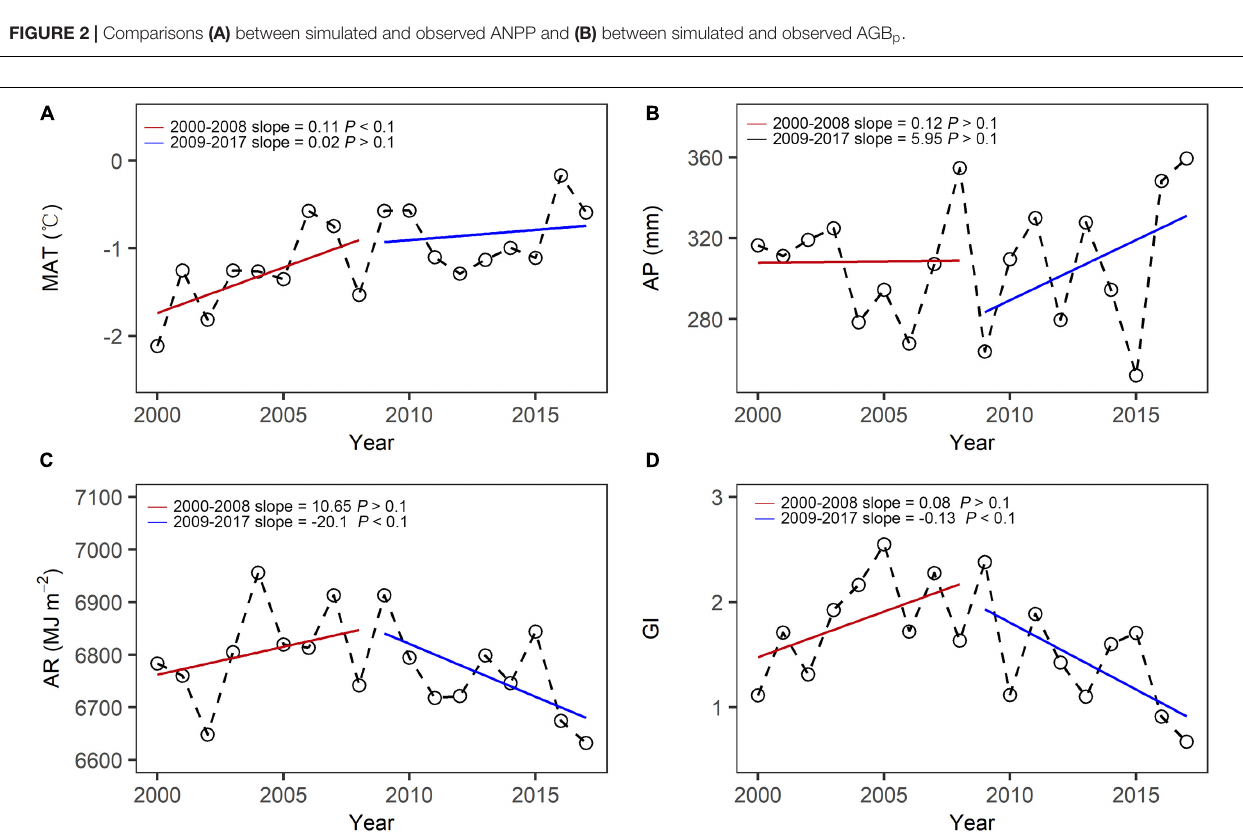
FIGURE 3 | Inter-annual dynamics of (A) MAT, (B) AP, (C) AR, and (D) GI before and after the implementation of the “ Ecological Security Barrier Protection and Construction Project.”